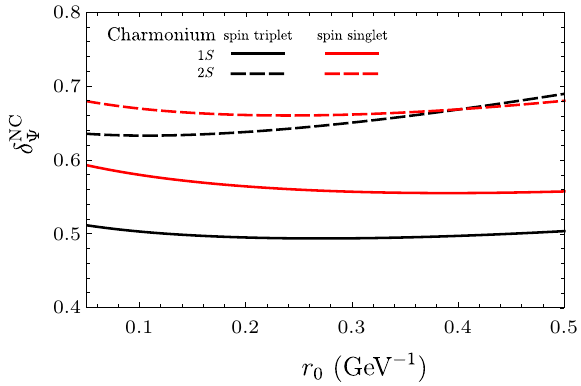
Figure 5 . The non-Coulombic corrections δ NC and 2 S (dashed lines) states, for spin triplet (black) and spin singlet (red). The r mild for the range 0.1 GeV − 1 < r